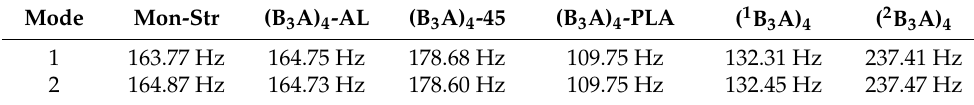
Table 4. The natural frequency of different decoupled parallel XY MPSs.